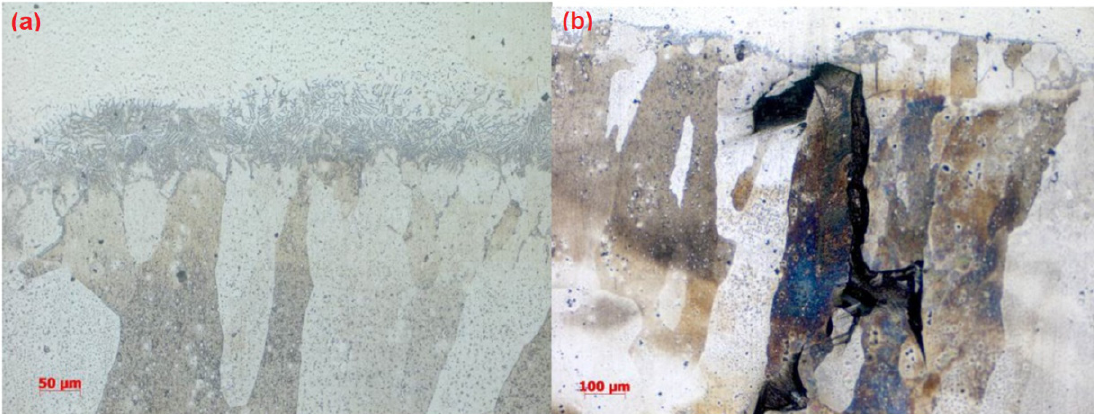
Figure 5. Metallographic analysis of the manual TIG welded sample: melting zone ( a ) and coating layer ( b ).